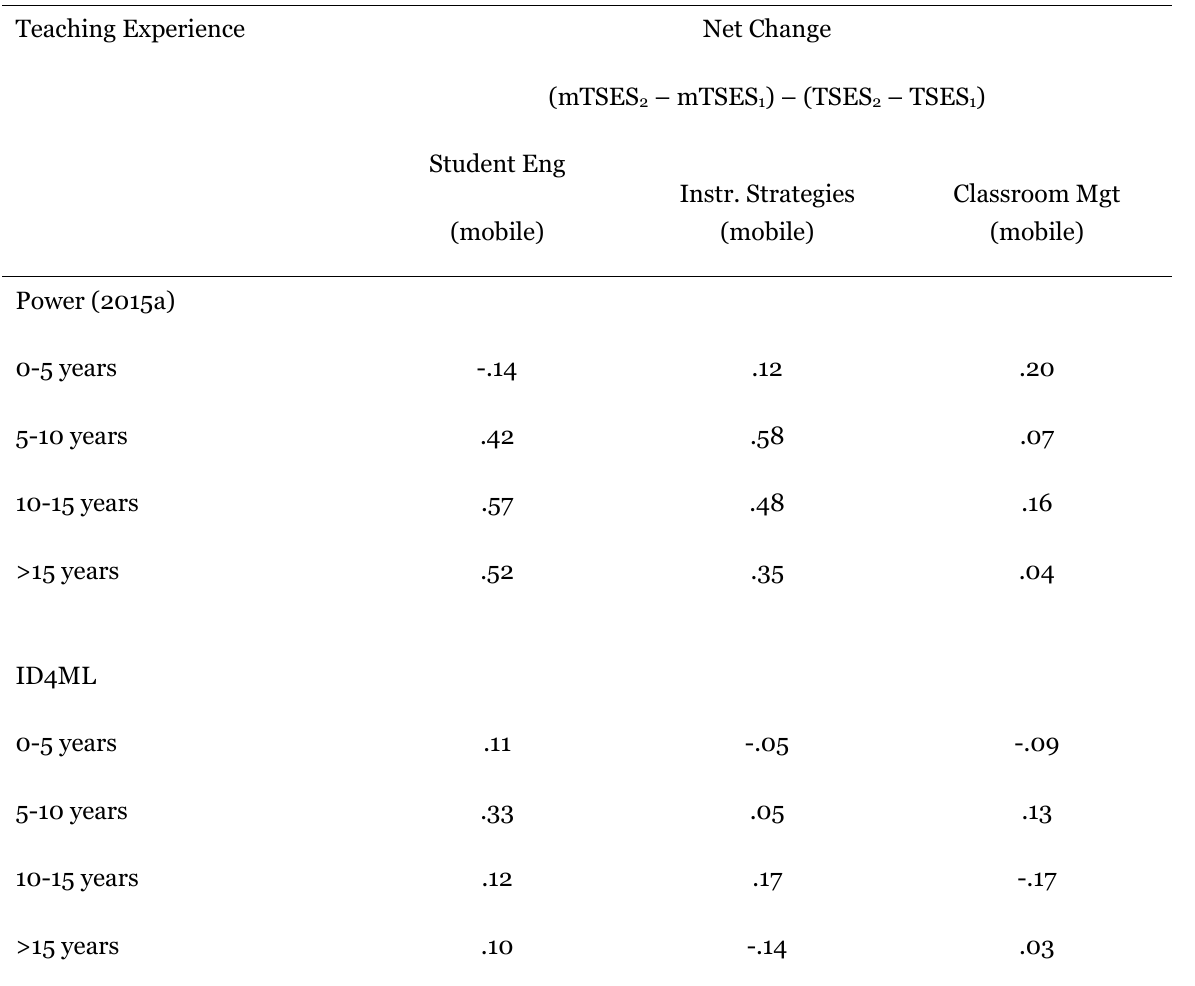
Table 7 Net Change (Intervention Effect) According to Years of Teaching Experience Teaching